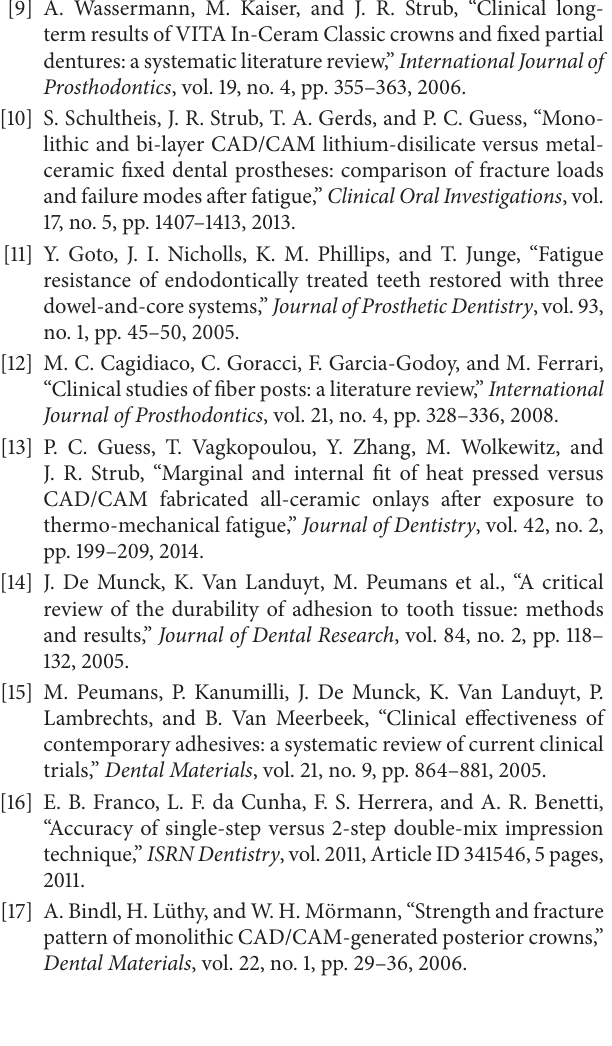
The endocrown ceramic restoration using the VITA-PM9 system is a feasible and conservative approach for mechanical and aesthetic restoration of nonvital posterior